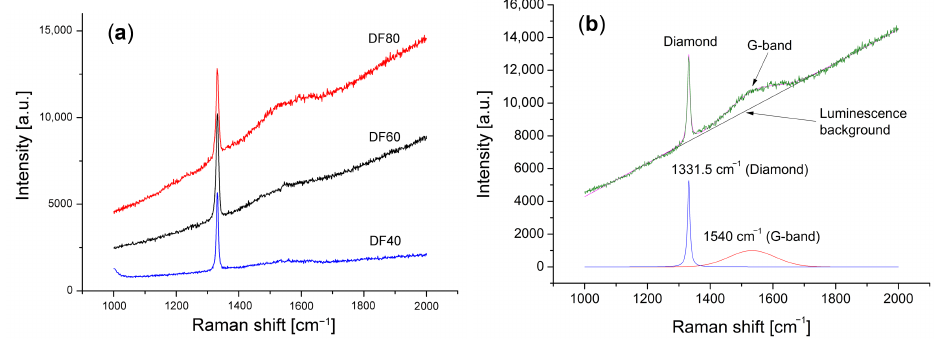
Figure 3. The Raman spectra ( a ) corresponding to the investigated diamond’s films presented in Figure 1, ( b ) numerical deconvolution of the DF80 spectrum.